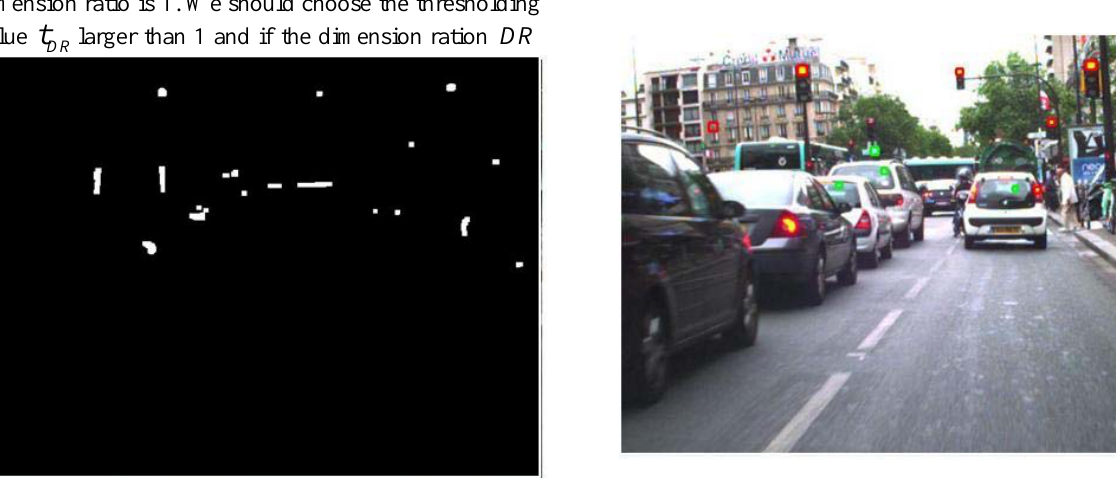
Fig. 3. Result image of noise removal using opening morphological operation with a 5x5 rectangle structural element